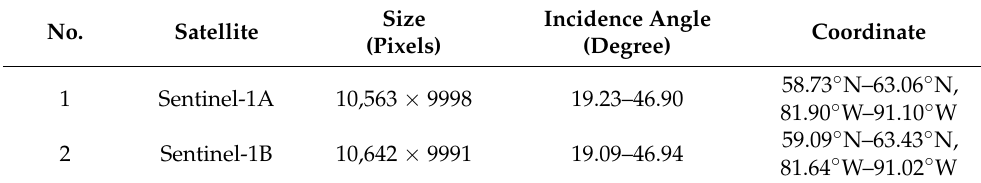
Table 1. Parameters of collected SAR data.